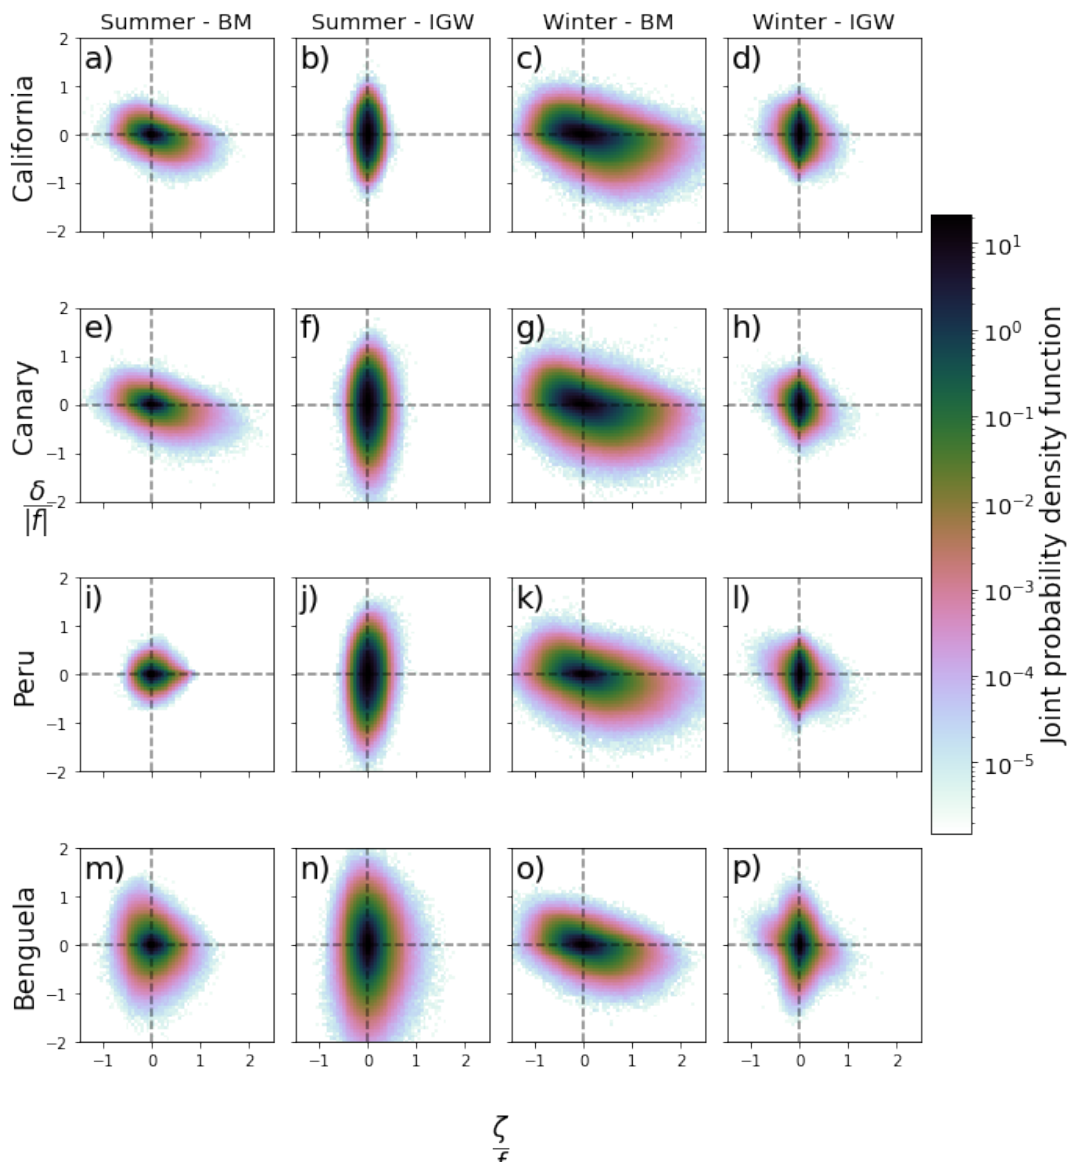
Figure 8. Joint probability distribution of ζ ( x -axis) and δ ( y -axis) at selected study areas within the California (26.64 ◦ N: ( a – d )), Canary (26.64 ◦ N: ( e – h )), Peru (21.61 ◦ S: ( i – l )), and Benguela (26.64 ◦ S: ( m – p )) current systems for both the balanced motion (BM) and internal gravity wave (IGW) regimes. Both vorticity ( ζ ) and divergence ( δ ) are normalized by f . Bin colors are presented on a logarith- mic